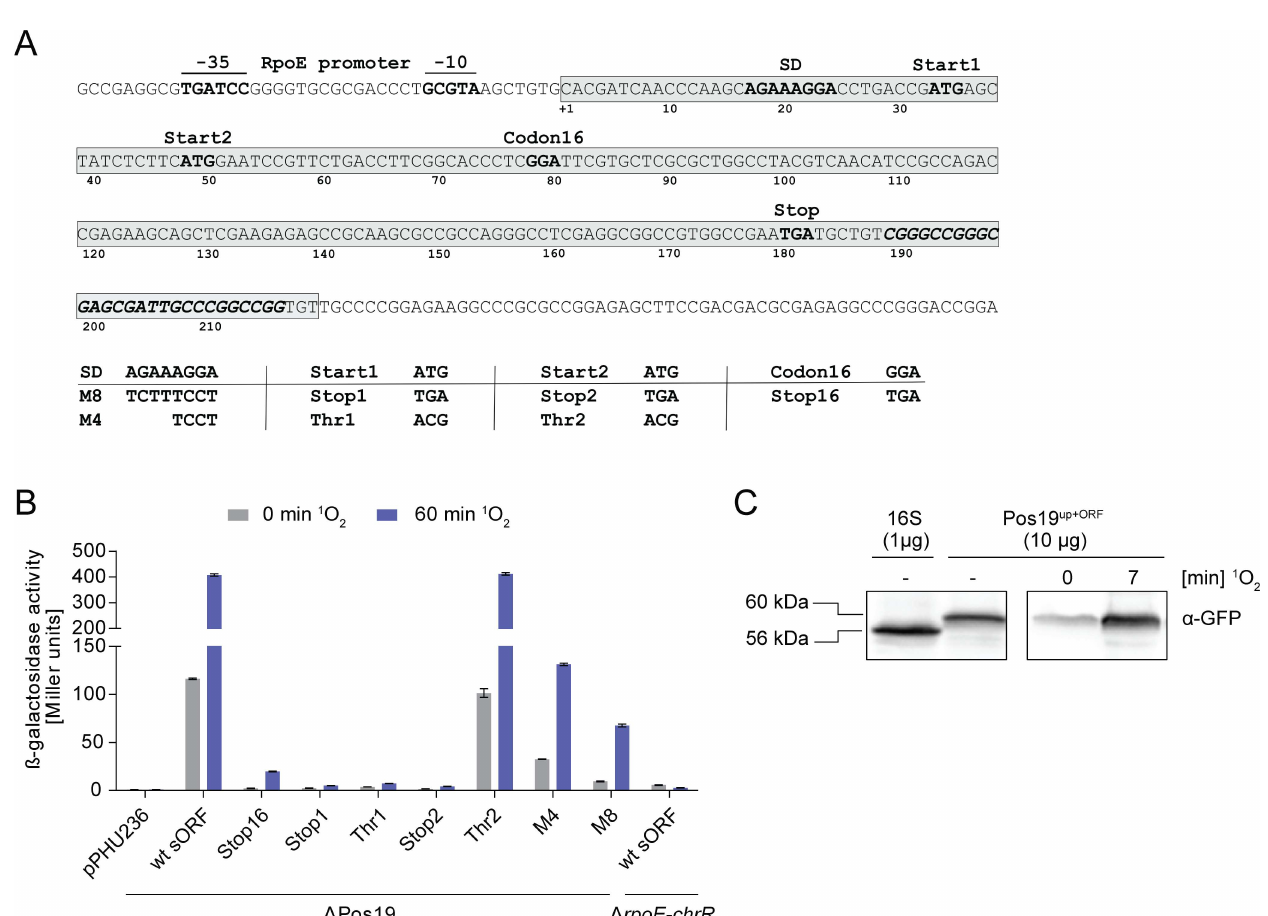
Fig 2. Pos19 is a coding sRNA. (A) Detailedillustration of the pos19 gene. Relevant features are shown in bold. The -35 and -10 motifs of the RpoE-dependent promoter are marked. The 219 nt long sRNA (shaded in grey) contains two potential ORFs with lengths of 150 (Start1) and 135 nt (Start2). The Rho-independent terminator (italic letters) was predicted by TransTermHP [27] and correlates with the 3’ end mapped by 3’ RACE. The Shine-Dalgarno(SD) sequence,the two start codons as well as one internal codon (Codon16)were mutated accordingto the chart belowthe sequence. (B) In vivo translation of the Pos19-sORF was monitored by translational lacZ fusions. A 300 bp fragment containingthe RpoE-dependent promoter and the first 178 bp of the pos19 gene (includingcodons 1–48) was fused to the promoter-less lacZ gene on reporter plasmid pPHU236. The wild-type(wt) sORF was subsequently mutated as shown in (A). The fusion plasmids and control plasmid pPHU236 were transferred to R . sphaeroides Δ Pos19 or strain TF18, which lacks the rpoE-chrR locus. The corresponding strains were subjected to 1 O 2 stress for 60 min with samples collectedat the indicatedtime points. ß-galactosidase activities were measured from biologicaltriplicates with technical duplicates. Error bars represent the standard error of the mean. (C) In vivo translation of the Pos19-sORF was monitored by translational eCFP fusion. The Pos19 peptide, C-terminally fused to eCFP (Pos19 up+ORF ), was detected with a polyclonal anti-GFP antibody on a Western blot. Cultures were stressed as describedfor Fig 1 and samples were withdrawn at the indicatedtime points. The amount of total protein extracts is shown in brackets. Protein from a strain carrying the pBE_eCFP::eCFP with 16S rRNA promoter (16S) was used as control. The size difference between control and Pos19 fusion of around 4 kDa corresponds to molecularweight of the predicted Pos19